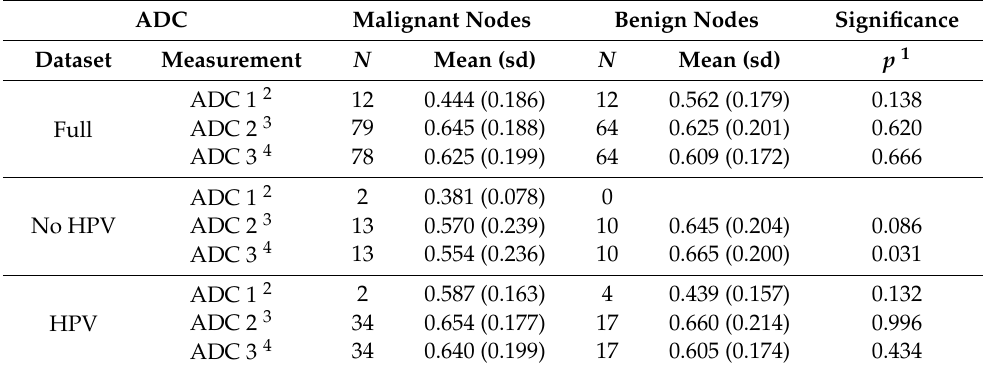
Table 2. Difference in minimum ADC between cytologically malignant and benign PET-positive nodes. ADC Malignant Nodes Benign Nodes Significance Dataset